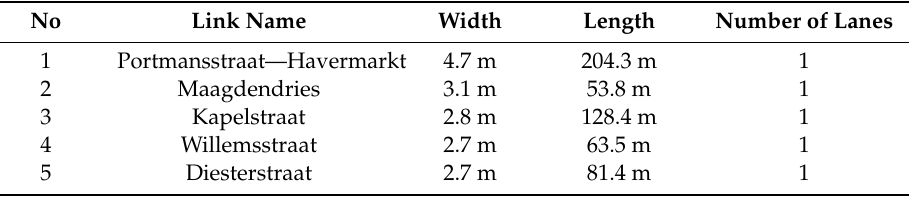
Table 1. Road Network in PTV